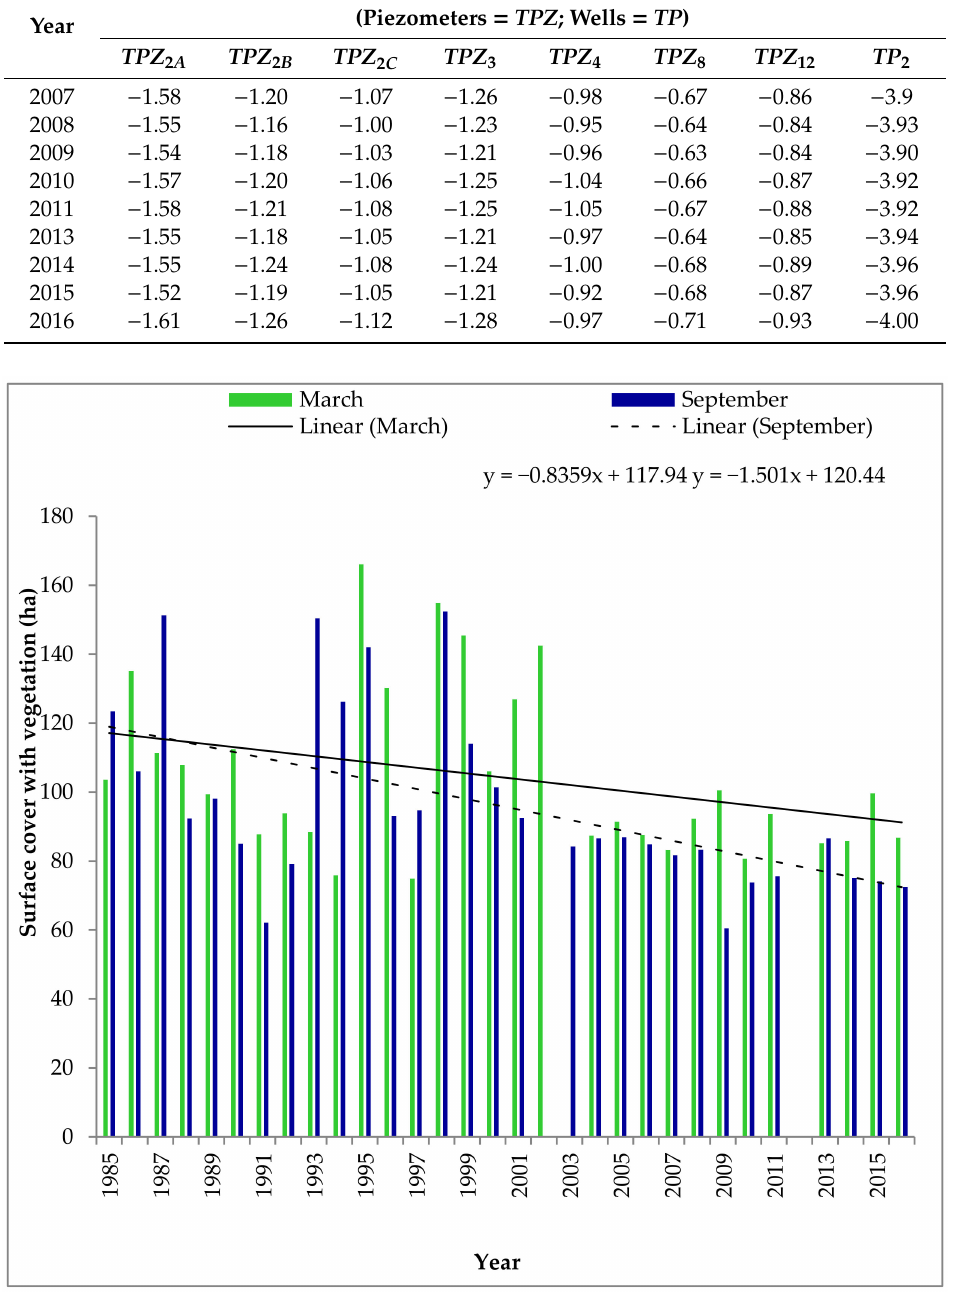
Figure 5. Evolution of the area of vegetation cover of the Tilopozo wetlands (from Landsat TM and OLI-derived normalized di ff erential vegetation index (NDVI) data) for March and September between 1985 and